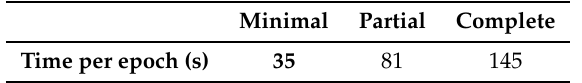
Table 5. Seconds per epoch for different padding strategies. The highest performance is shown in